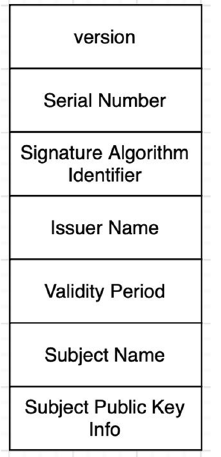
Figure 5. X.509 certificates structure.